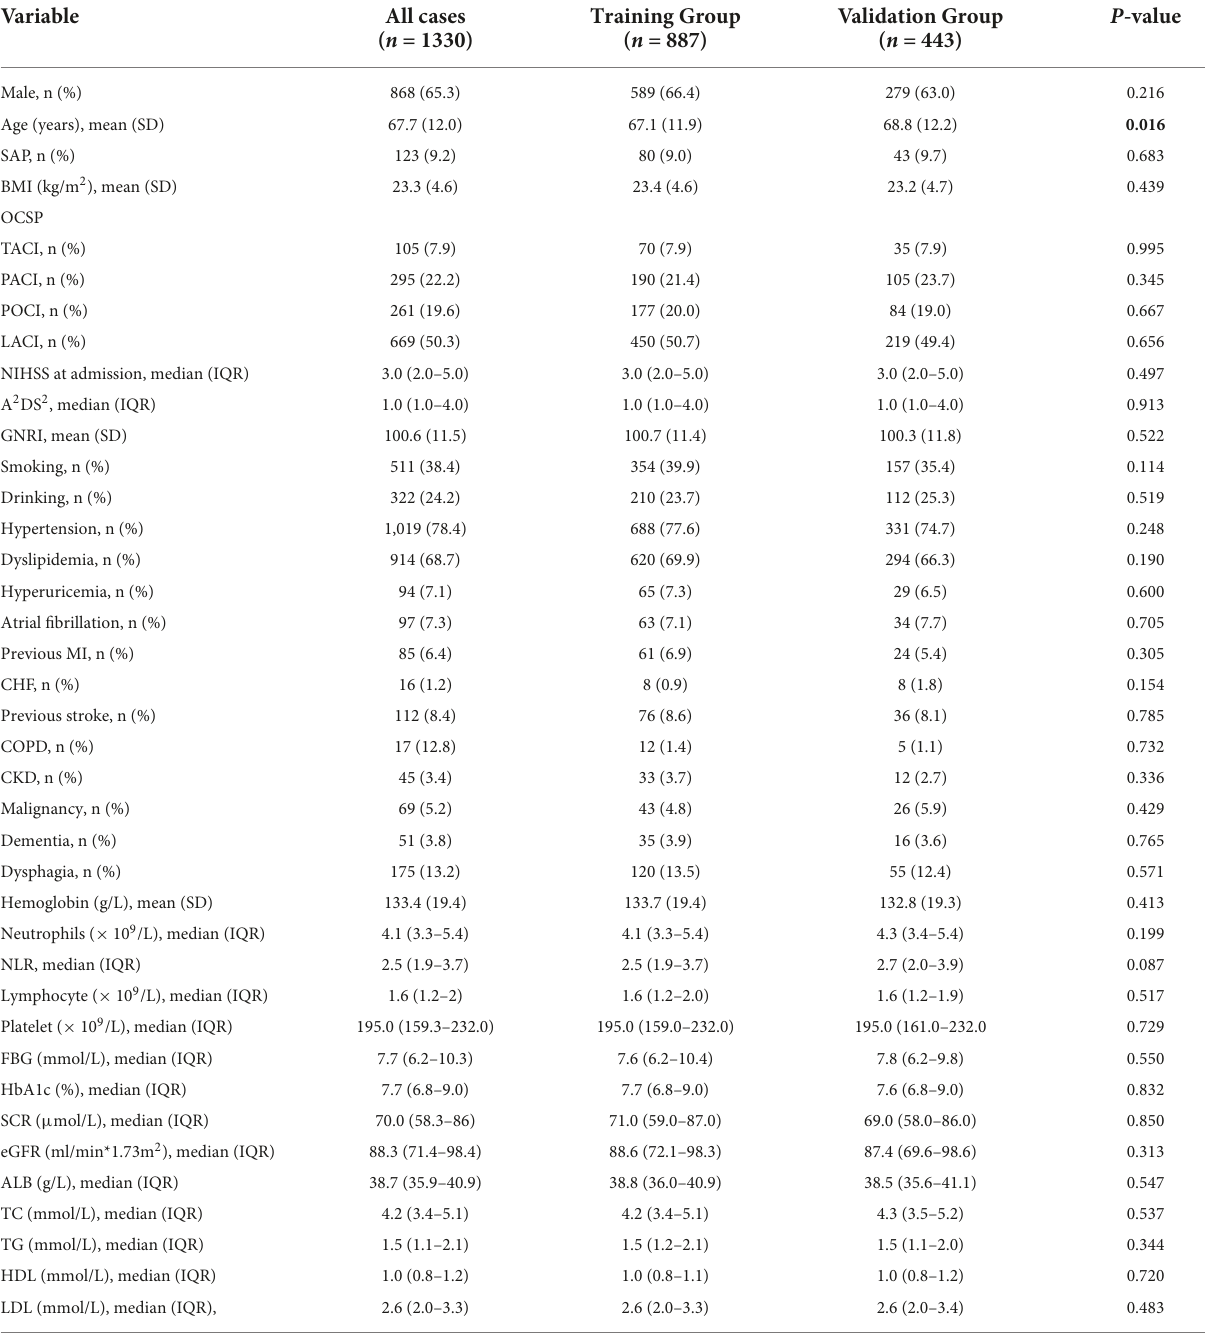
TABLE 1 Demographic and clinical variables of